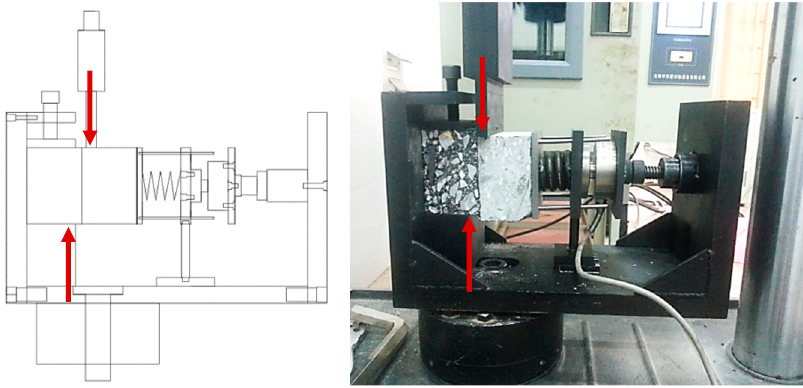
Figure 2. Direct shear test design and test device.